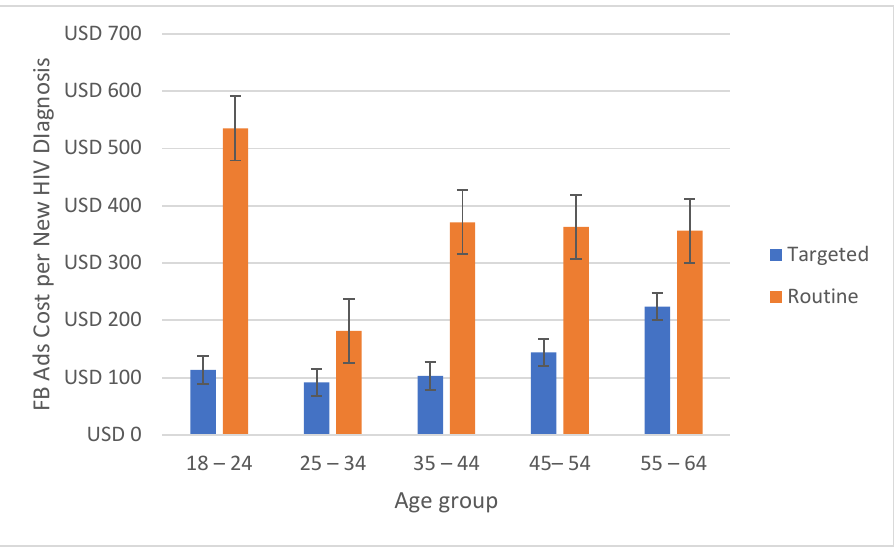
Figure 1. Estimated Ad cost per new HIV diagnosis comparison between targeted and non-targeted models for age groups in Texas, USA.